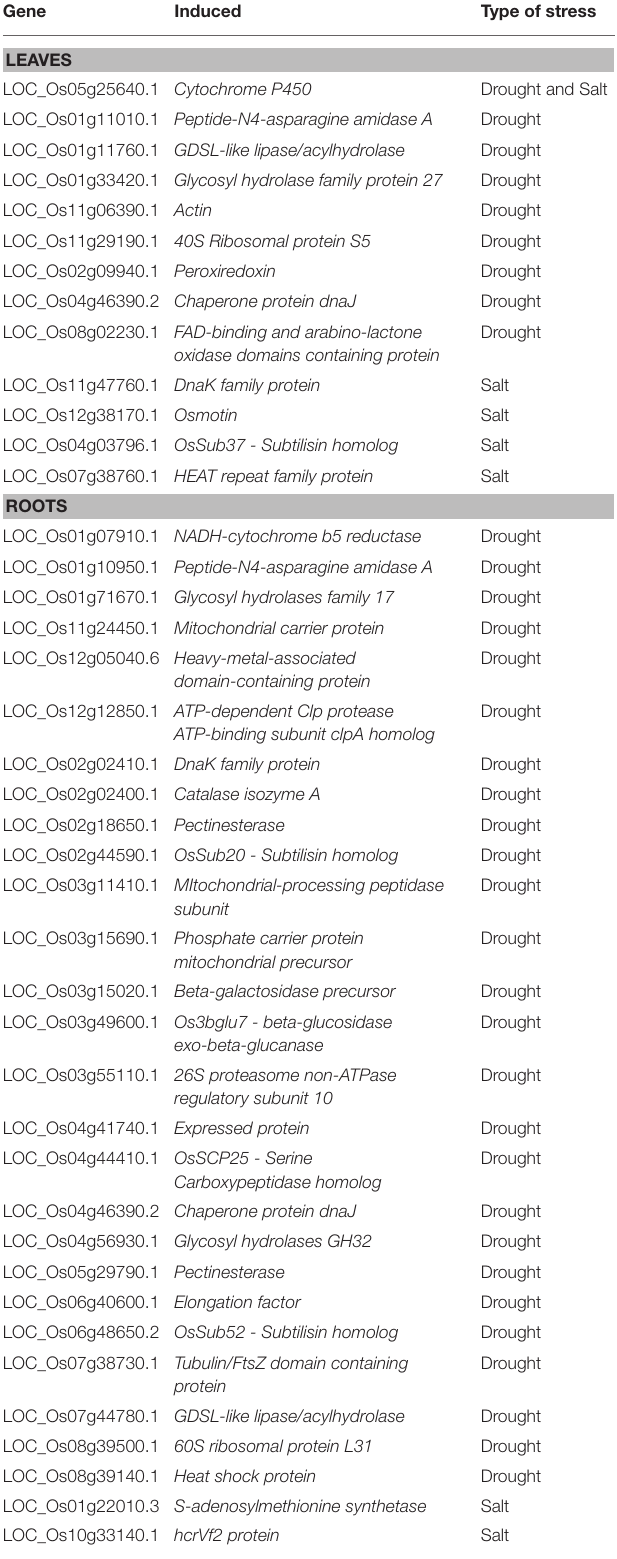
TABLE 2 | List of drought- and salt-responsive genes in O. sativa . Gene Induced Type of